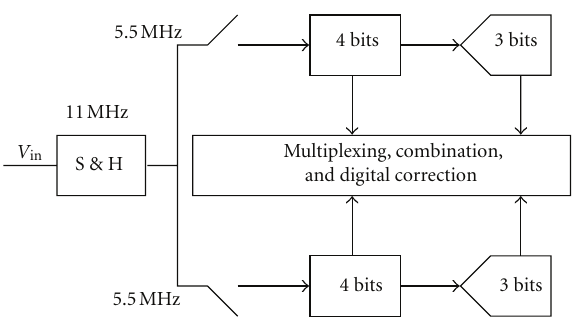
Figure 3: 2-ch x 2-st ADC for Bluetooth standard.